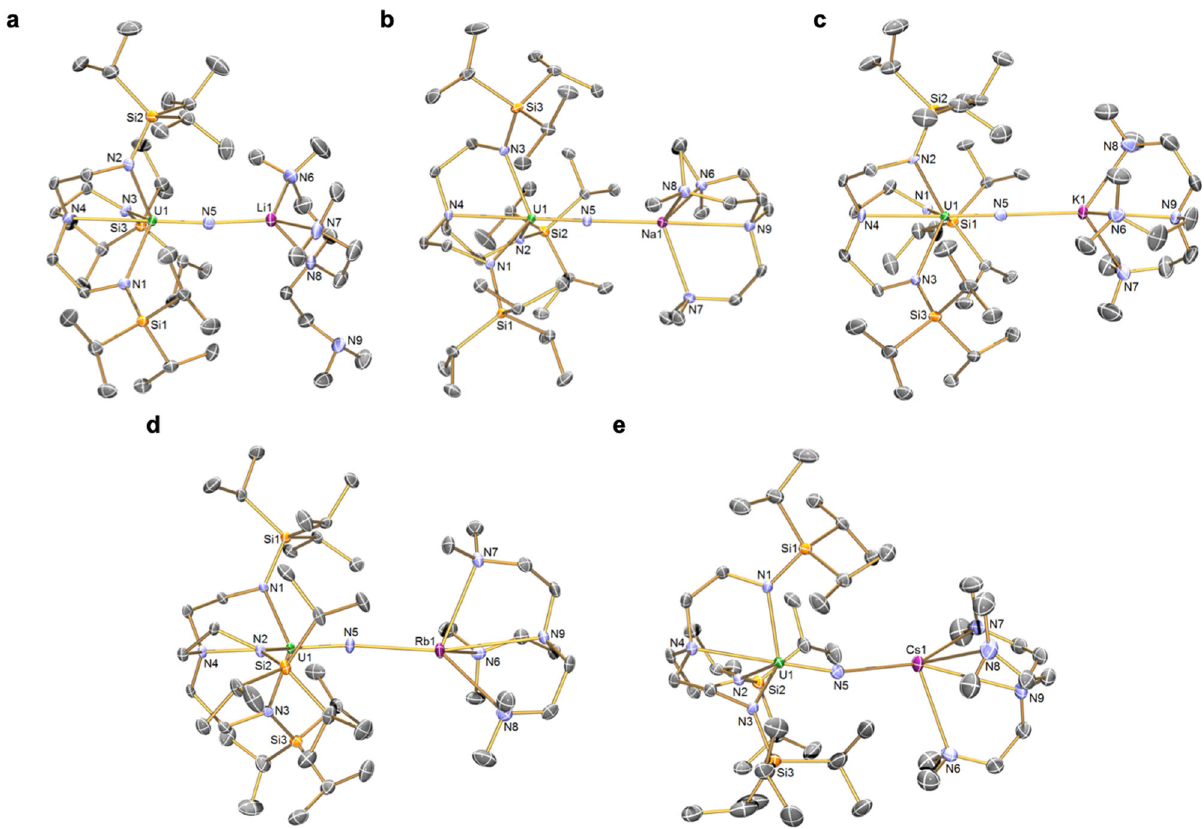
Fig. 3 Solid-state single crystal structures of uranium(V)-nitrides (5M) at 150 K with 40% probability displacement ellipsoids. a complex 5Li . b complex 5Na . c complex 5K . d complex 5Rb . e complex 5Cs . In each case all non-imido hydrogen atoms, lattice solvent molecules, and disorder components are omitted for